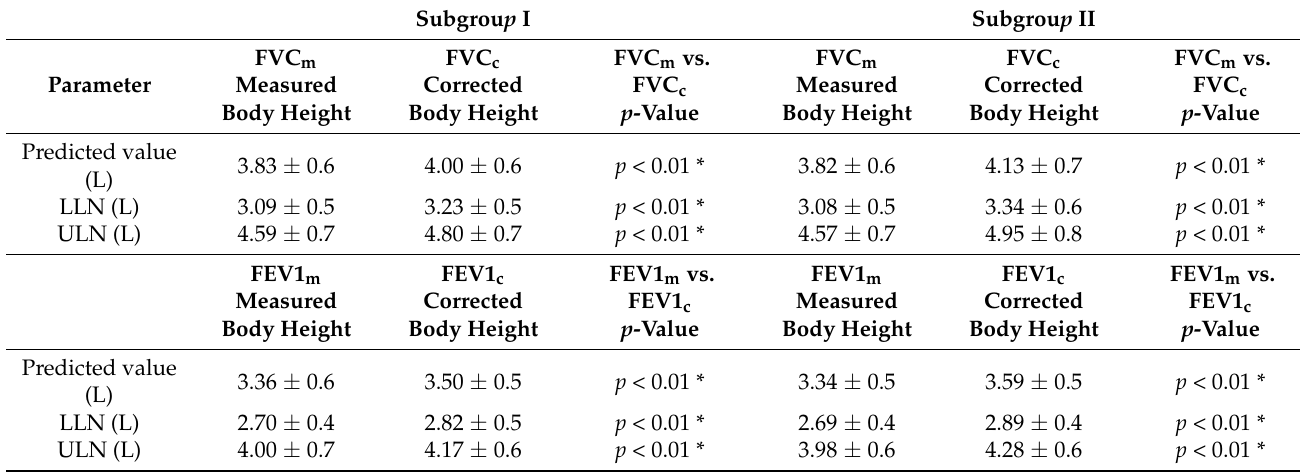
Table A1. Comparison of the predicted values of the pulmonary parameters calculated (GLI 2012, [17]) for the measured versus the corrected body height in subgroup I, N = 84, and subgroup II, N = 36.